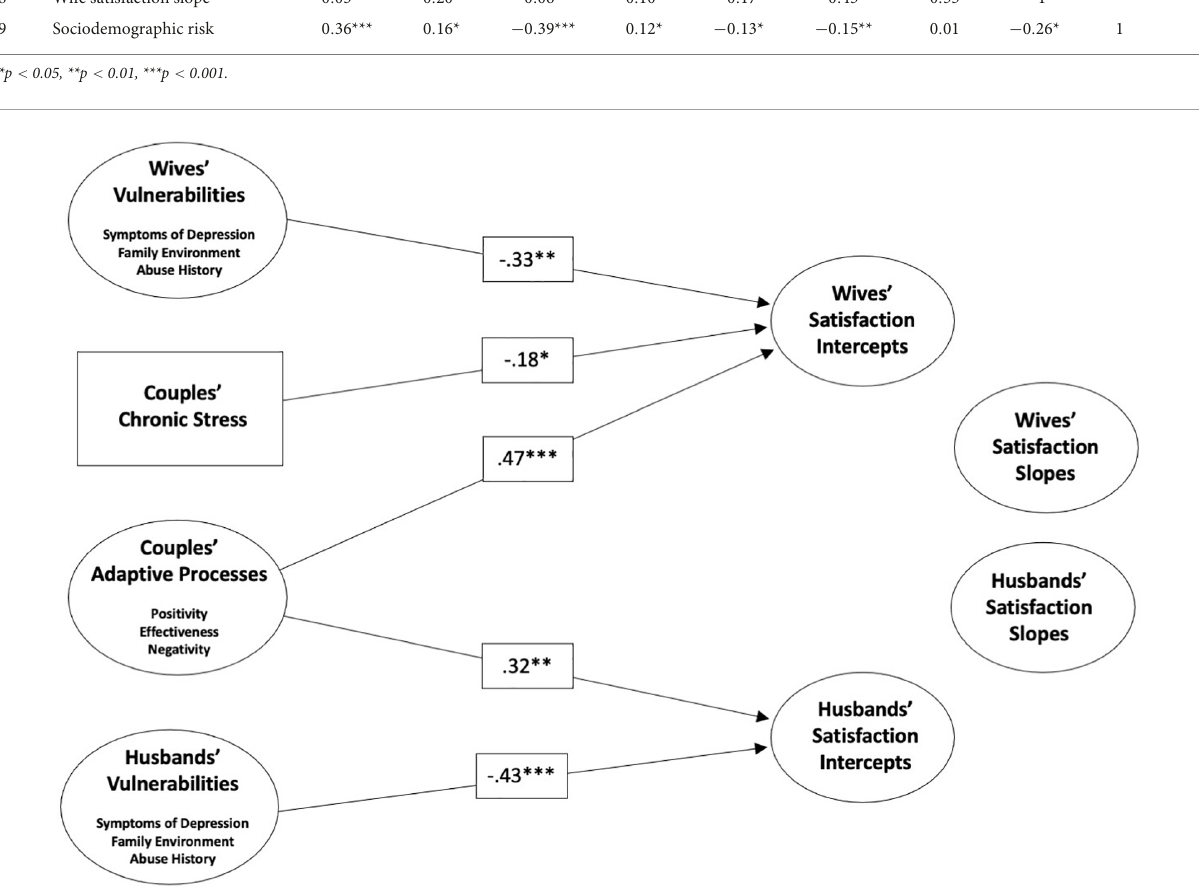
FIGURE1 Structural equation model relating vulnerabilities, chronic stress, and couples’ adaptive processes to wives’ and husbands’ satisfaction intercepts and slopes. Only significant paths are shown. N = 388 couples. ∗ p < 0.05, ∗∗ p < 0.01, ∗∗∗ p < 0.001.